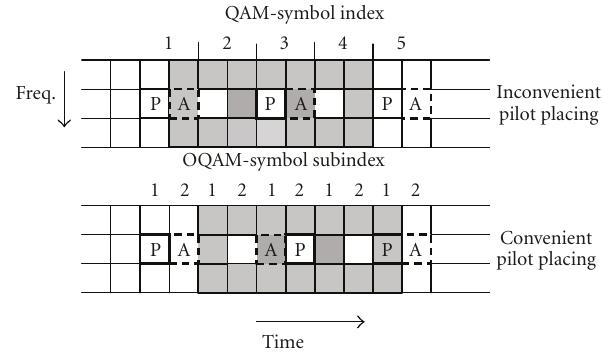
Figure 5: Alternative pilot and data allocations for FBMC with DL- PUSC-like pilot pattern. P: Pilot. A: Auxiliary Pilot.